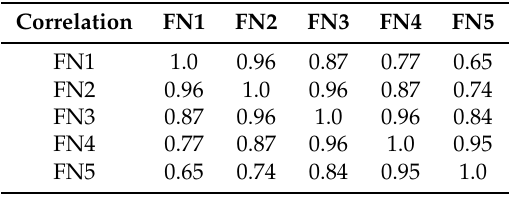
Table 1. Correlation matrix of the ICE U.K. Natural Gas Futures prices with maturities from 1–5 months.